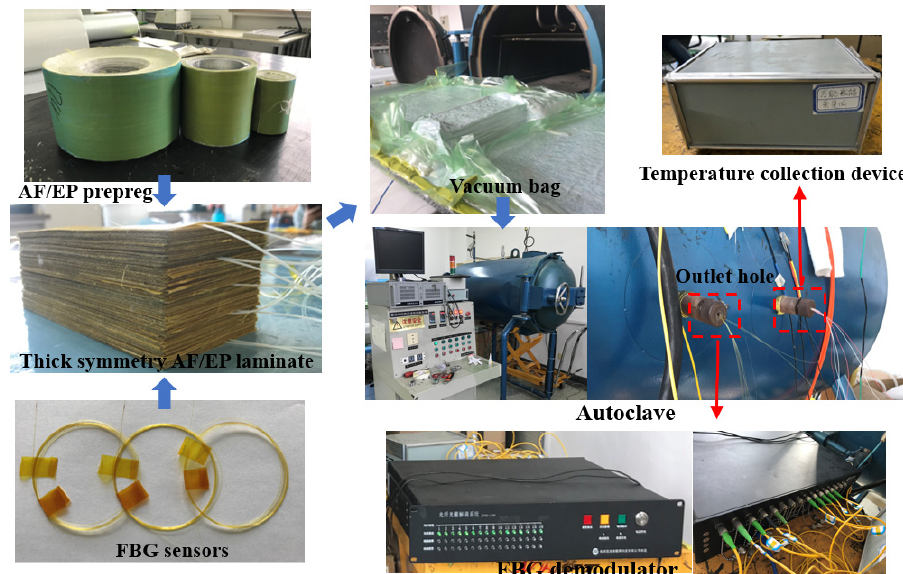
Figure 6. Curing monitoring experiment process.